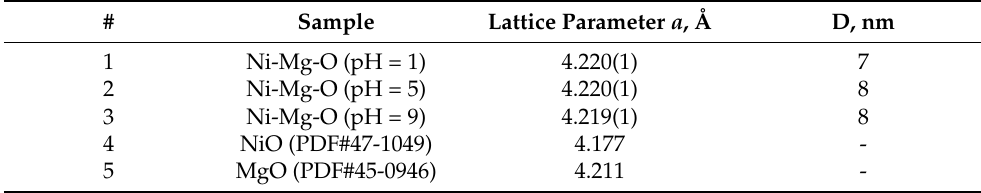
Table 2. The lattice parameters ( a ) and estimated crystallite size (D) of the studied samples and NiO and MgO